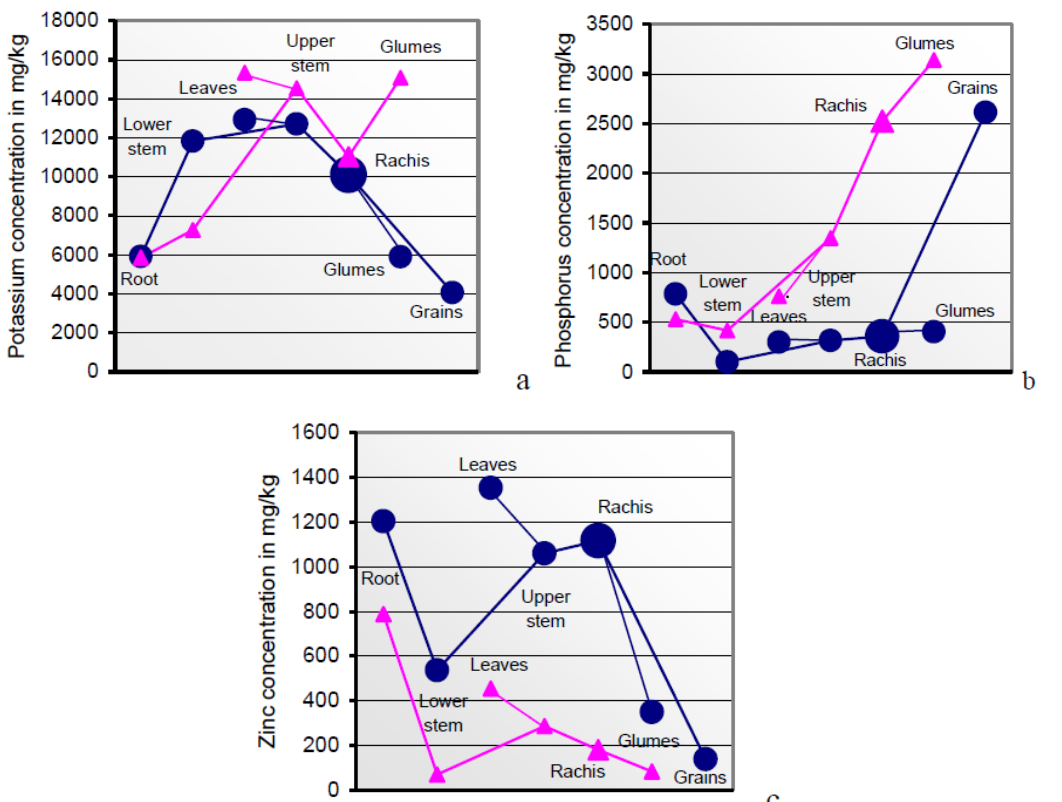
Figure 6. Course of K ( a ); P ( b ); and Zn ( c ) concentrations from roots to mature grains of whole wheat plants cv. JB Asano analyzed at anthesis (bright curves) and maturity (dark curves). Note the role of leaves and glumes as sink tissues and the concentration differences between both rachis-borne structures of grains and glumes in the plants grown on the metalliferous soil A. Compare Table 3 for significant differences within the flow of the individual elements.